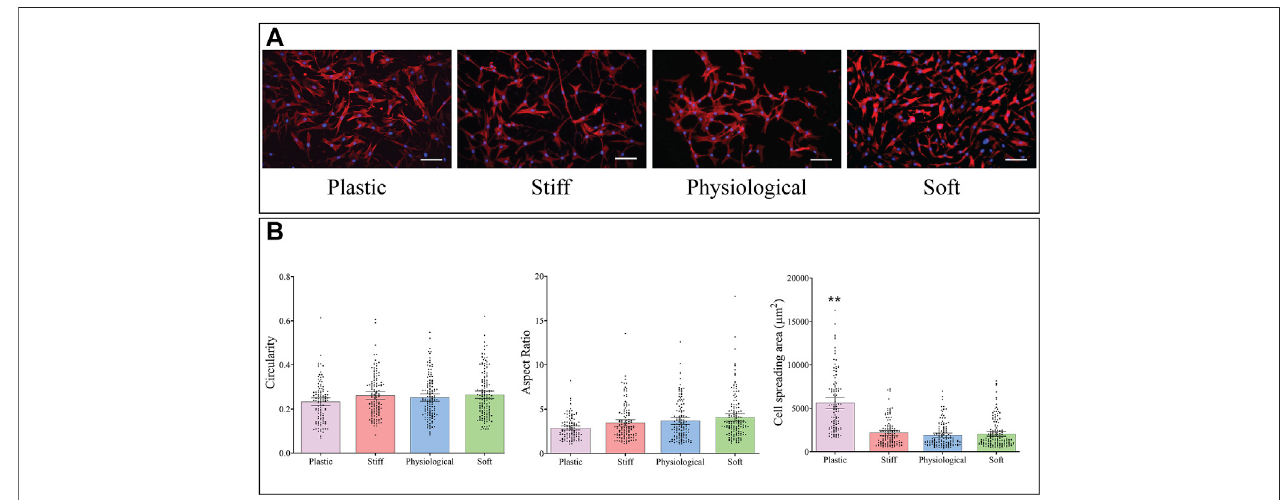
FIGURE 3 | Morphology of TDCs cultured on substrates of different stiffness. (A) Representative images of cells stained with DAPI (blue, nucleus) and Alexa-Fluor 594Phalloidin(red,actin fi laments)(Scalebar=100 µm). (B) MorphologicalparametersofTDCs – circularity,aspectratio,andareaweremeasuredincellsonthedifferent substrates. Aspect ratio; higher values indicate a more elongated cell shape. Dots represent individual measurements, means and 95% CI are indicated. Groups were compared by Kruskal Wallis test. ** p < 0.01in comparison to substrate with physiological